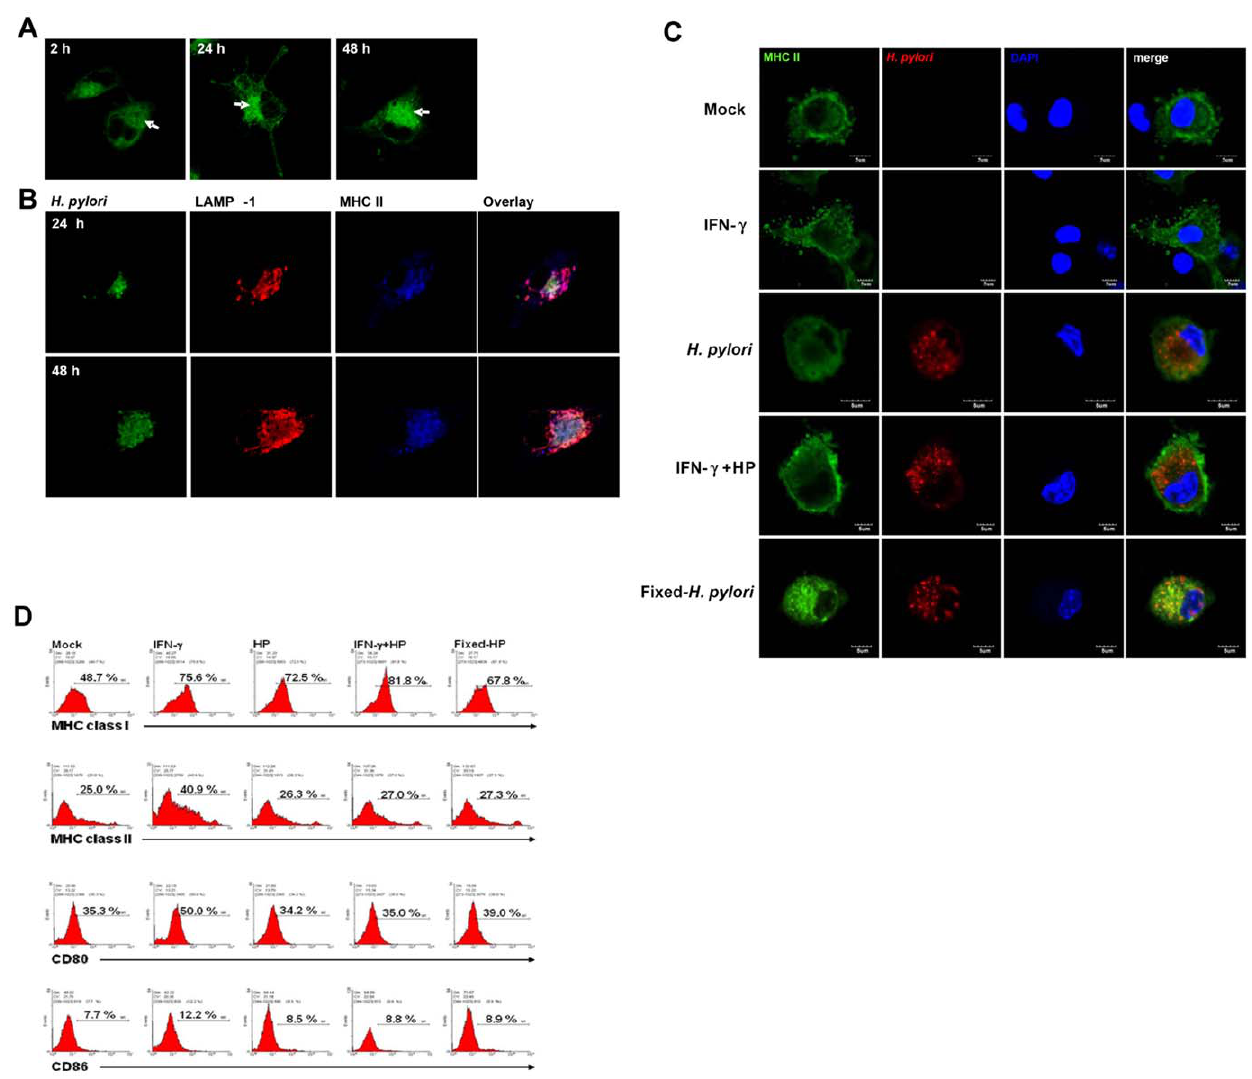
Figure 4. MHC class II cell surface expression is inhibited by H.pylori . BMDCs were infected with H. pylori at m.o.i.=10. At 2, 24, or 48 h post infection, the infected cell was stained with anti-class II antibody only (A) or anti- H. pylori antibody (green), anti-LAMP-1 antibody (red), or anti-class II antibody (blue) (B). Confocal images (arrow) shows MHC class II expression on the infected BMDCs. Arrows show the MHC class II accumulated in cytoplasm (A). Confocal images show the co-localization of H. pylori , LAMP-1 and MHC class II molecules on infected BMDCs at 24 and 48 h post infection (B). (C) H. pylori -infected cells were stained with anti-class II antibody (green) and anti- H. pylori antibodies (red), and DAPI (blue). Confocal images shows MHC co-localization of class II and H. pylori -containing vesicle on various treatment groups (mock control, IFN- c treatment, H. pylori infected, H. pylori with IFN- c or formalin fixed- H. pylori ) at 24 h post treatment. (D) Surface class II expression on H. pylori -infected BMDCs. H. pylori - infected cells were surface stained with anti-class I, class II, CD80, or CD86 antibody, and analyzed with Flow cytometry. The percentage of stained antibody positive cells is depicted.